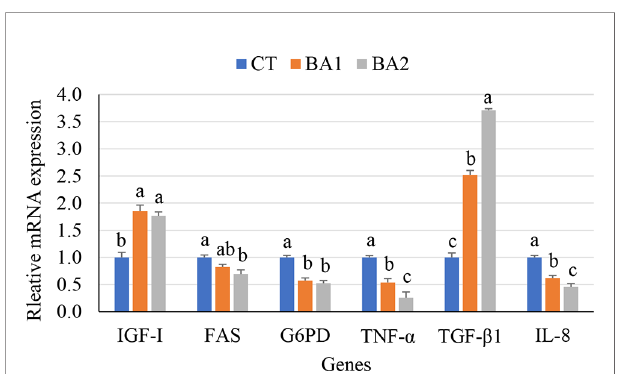
FIGURE 1 | Growth and immune-related gene expression in the liver of tongue sole fed a diet of BAs for 10 weeks. a,b,c Values with different superscript letters in the same row show signi fi cant differences ( p < 0.05). CT, basal diet; BA1 and BA2, bile acids were supplemented at the level of 300 and 900 mg/kg of basal